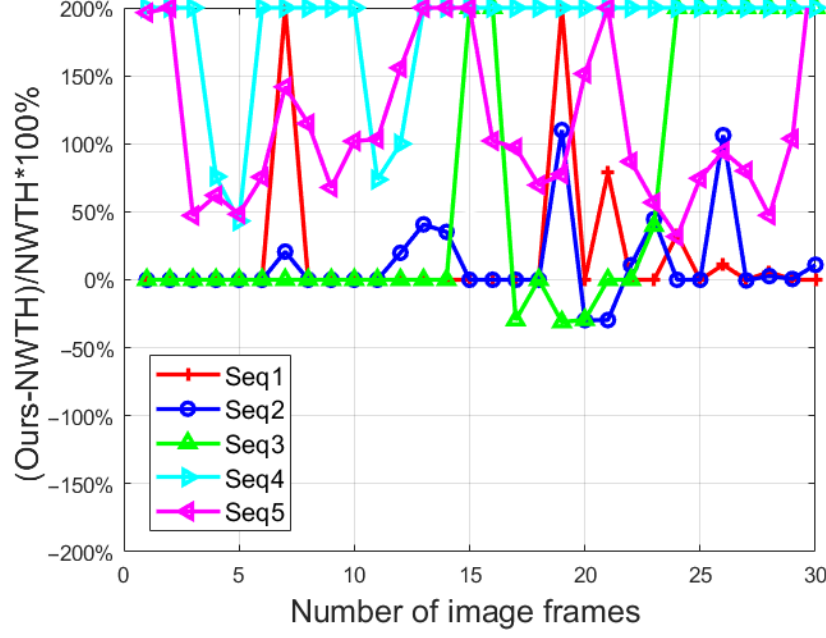
Figure 12. The ratio of SCR difference to NWTH. Capped at 200% for better presentation.